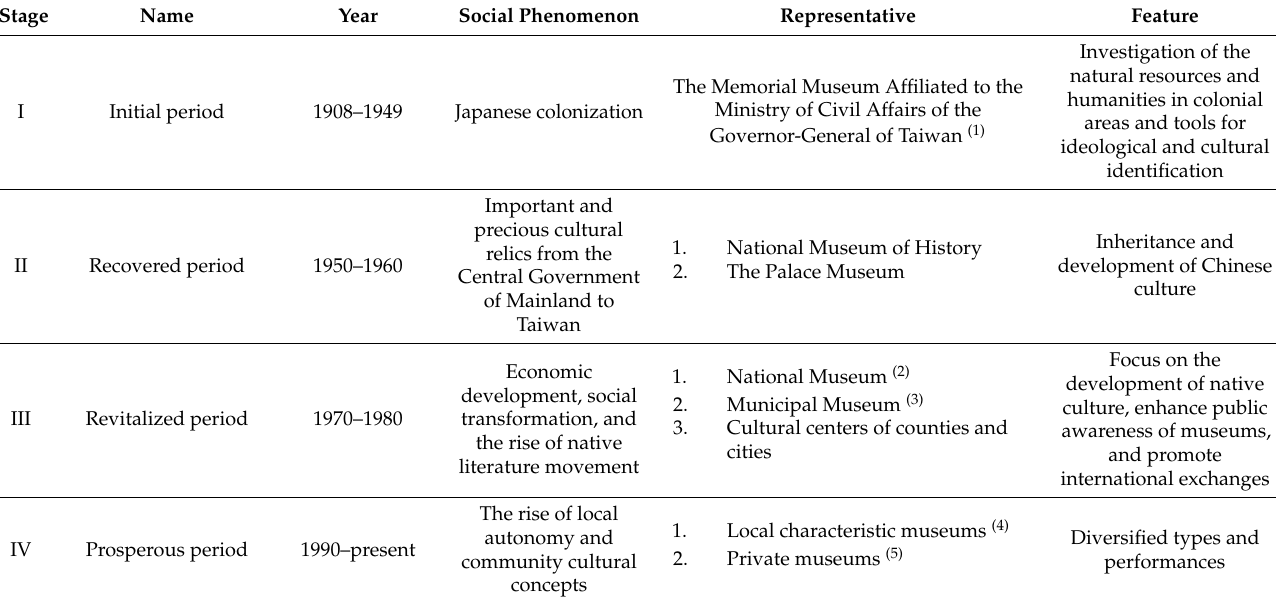
Table 1. The stages of museum development in